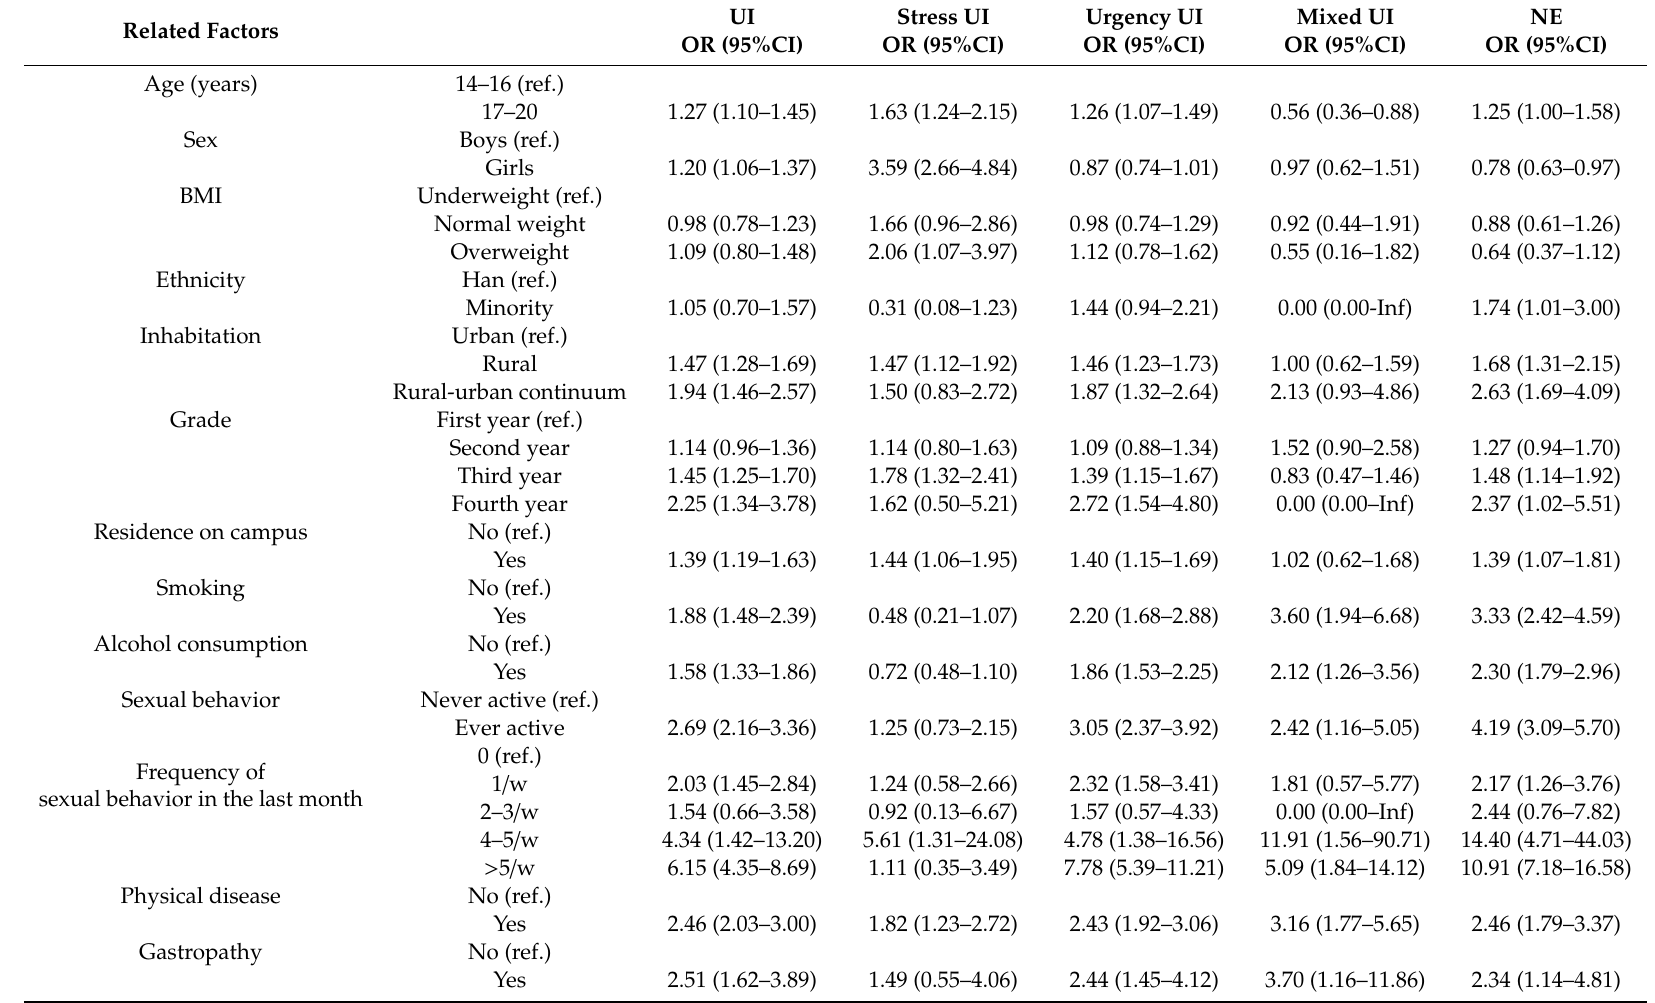
Table 4. Univariate analysis of factors associated with UI and